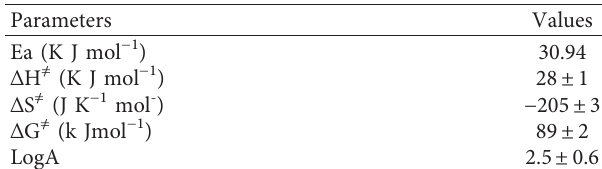
Table 2: Activation parameters with respect to uncatalyzed rate constant ( k u ).